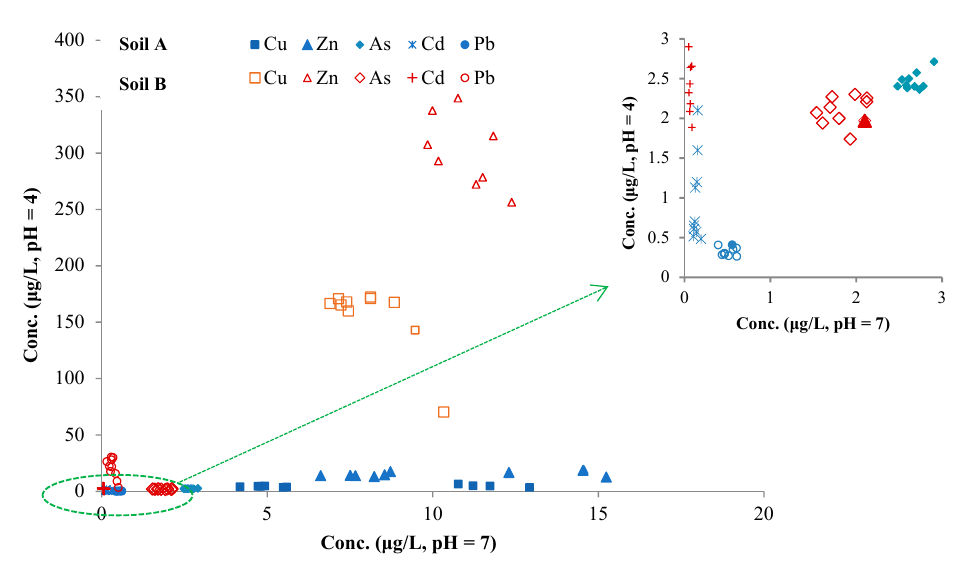
Figure 11. Comparison of concentrations of dissolved heavy metals and metalloids (HMs) under neutral (pH = 7) and acid (pH = 4) rainfall conditions.